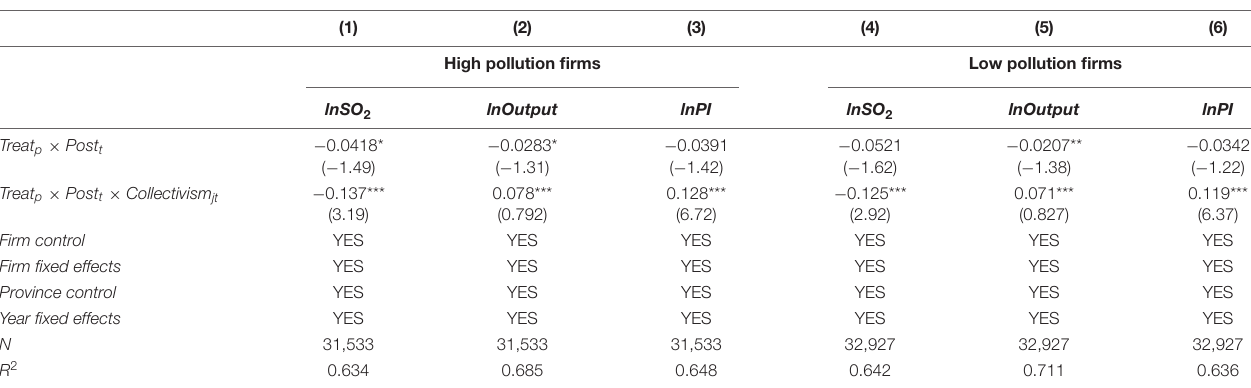
TABLE 6 | Heterogeneity of policy effects between high emission and low emission